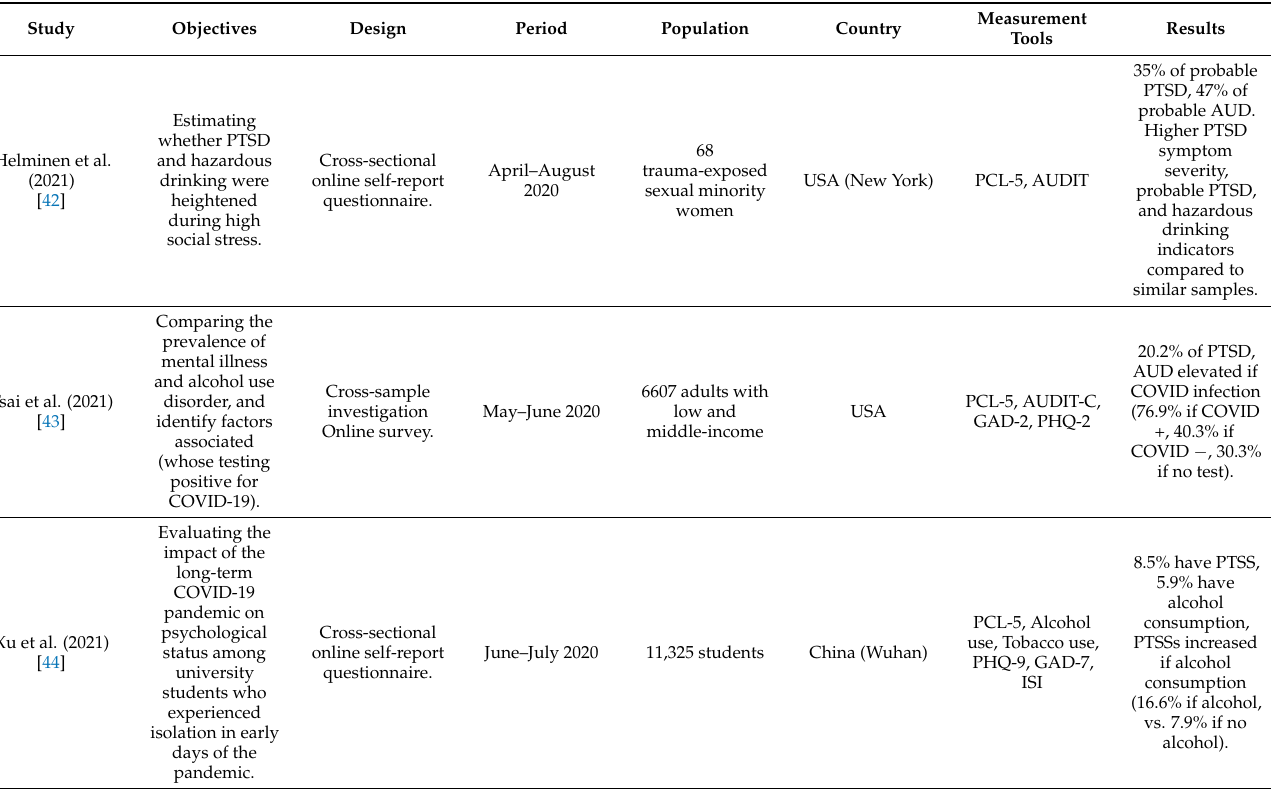
Table 6. Summary of the main data of the studies considered in this review—Other vulnerable populations (students, sexual minorities, and low- and middle-income